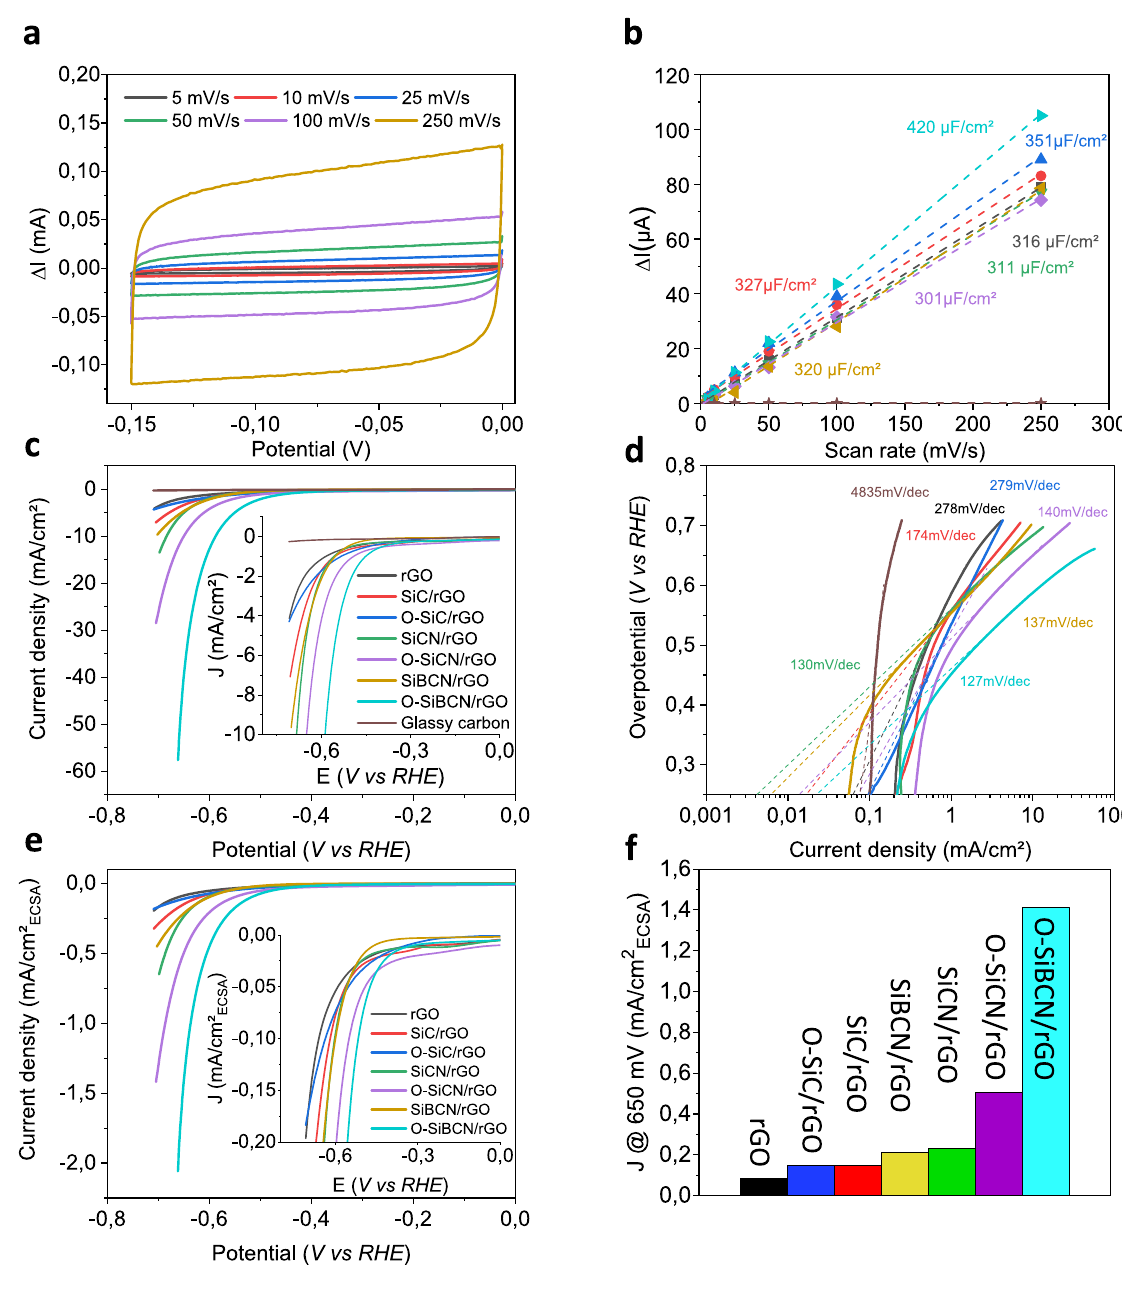
Figure 5. ( a ) Cyclic voltammetry curves for O-SiBCN/rGO composite. ( b ) Estimation of the double layer capacitance (C dl ) for the different electrodes. ( c , d ) Polarization curves and Tafel slopes of rGO, SiC/rGO, O-SiC/ rGO, SiCN/rGO, O-SiCN/rGO, SiBCN/rGO and O-SiBCN/rGO catalysts. ( e ) Corresponding ECSA-normalized polarization curves and ( f ) Histograms displaying the ECSA-normalized current density ( J ) at η = 650 mV for the different